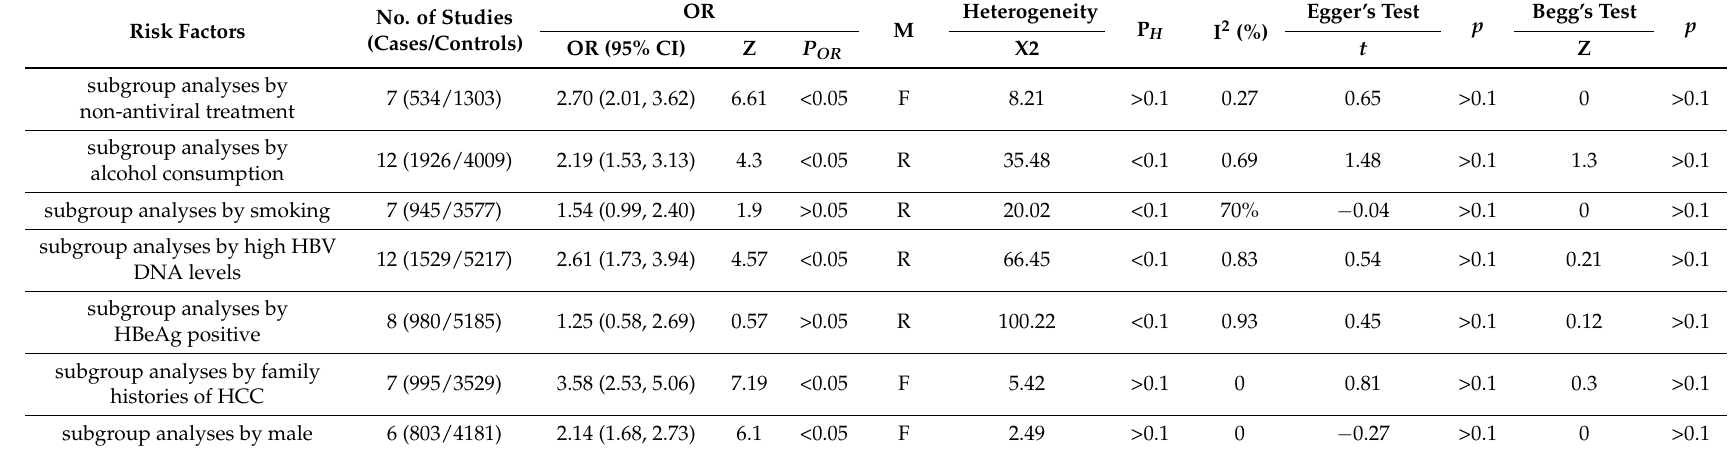
Table 2. The subgroup characteristics of possible risk factors associated with HCC in HBsAg-positive Chinese population.